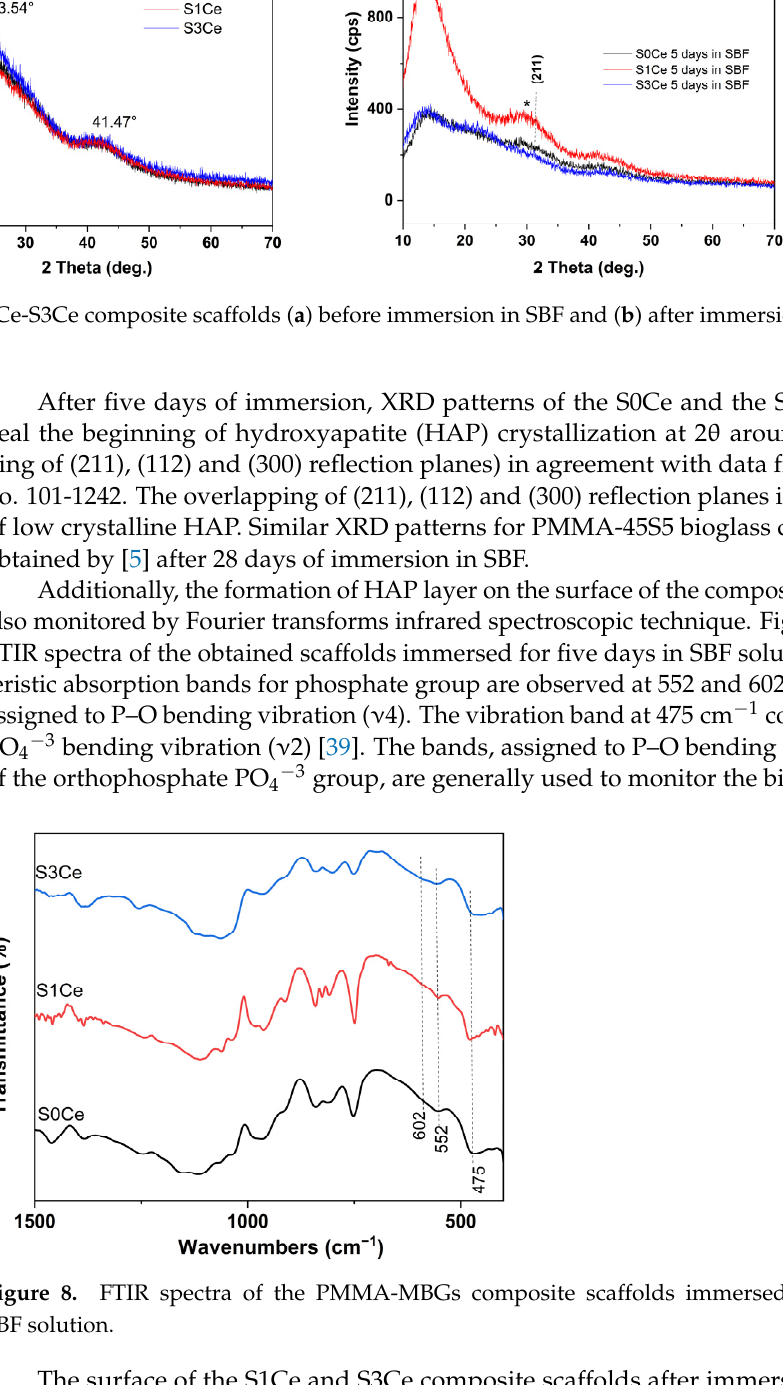
Figure 8. FTIR spectra of the PMMA-MBGs composite scaffolds immersed for five days in SBF solution.